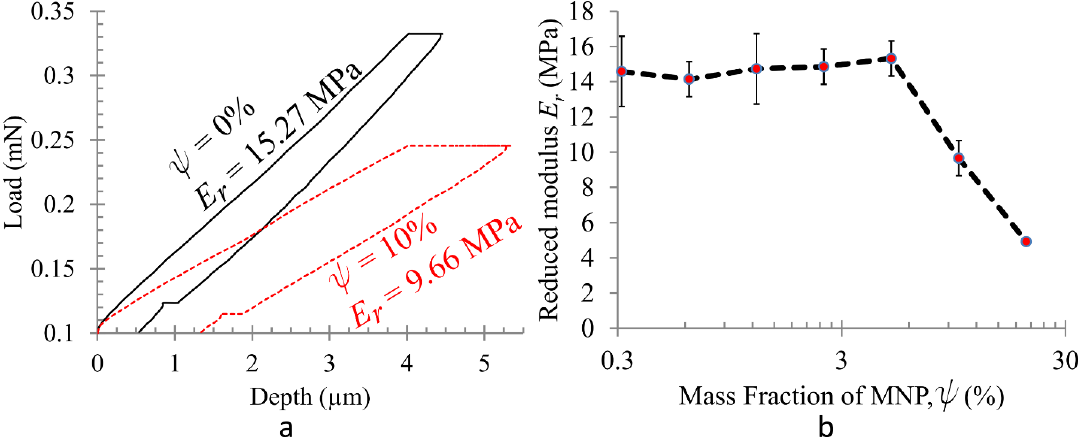
Figure 2. Effect of magnetite nanoparticle addition on the reduced modulus ( E r ), determined from homogeneous composite samples. ( a ) Pure PDMS is much stiffer than PDMS cured with ψ = 10% ( w / w ) MNPs, as determined from the slope of force-displacement curves obtained by instrumented nanoindentation; ( b ) E r does not change appreciably with ψ up to ψ =